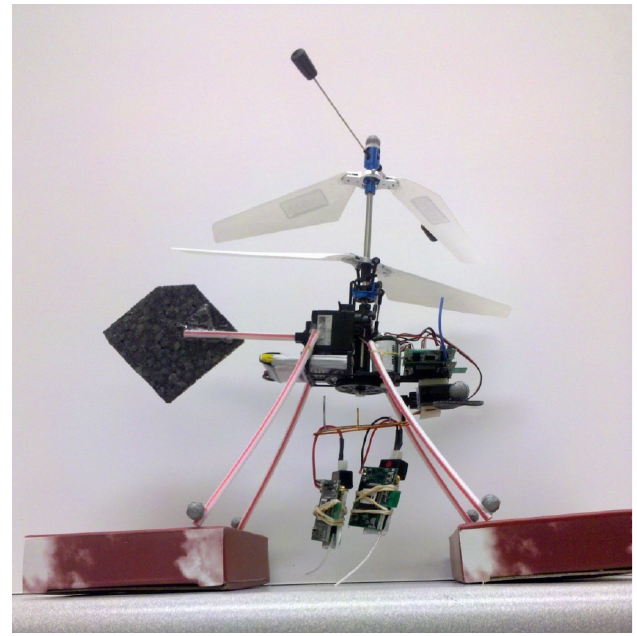
Figure 2. GINA hardware is used to implement an integrated MAV + WSN